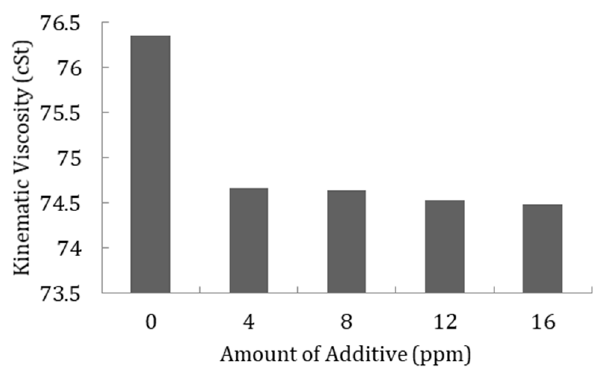
Figure 3. Effect of organic-based Mn additive on kinematic viscosity.